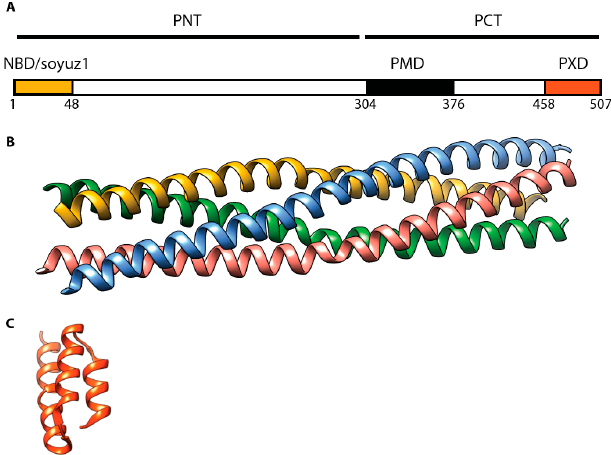
Figure 5. MeV P protein architecture. ( A ) Domain organization of the P protein. PMD: multimerization domain (residues 304–376) [56]; NBD: N0 binding domain (residues 1–48), including a soyuz1